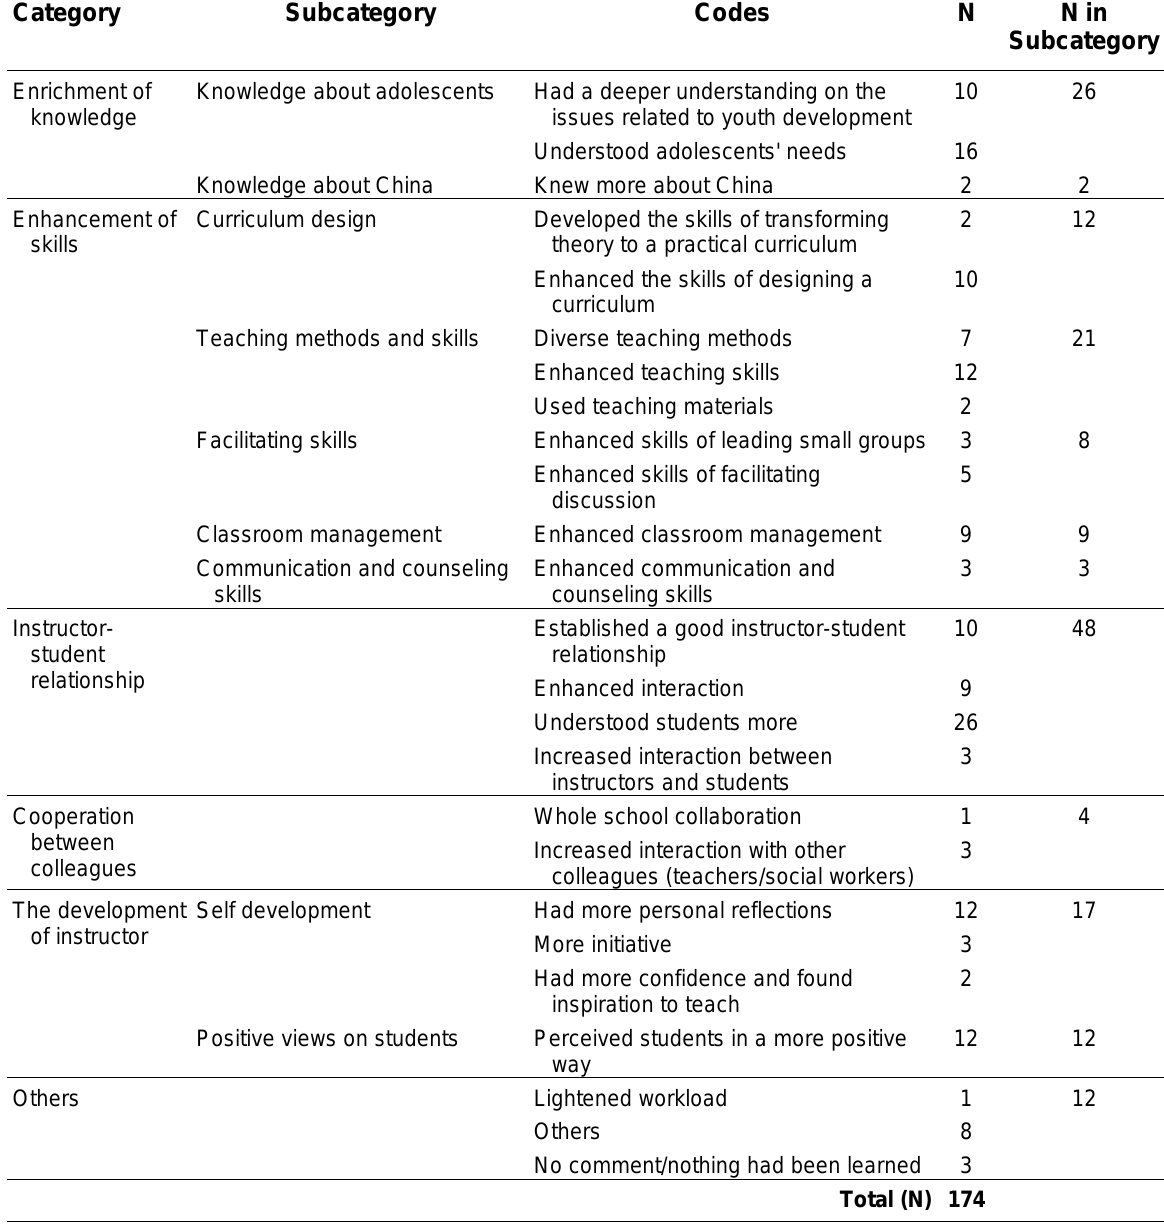
Summary of the Program Implementers' Comments on the Question: "What have the instructors learned in the implementation